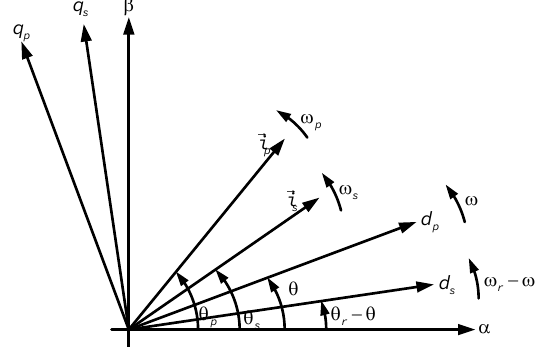
Figure 7. Reference frames and current vectors used in DSFM motor equations.